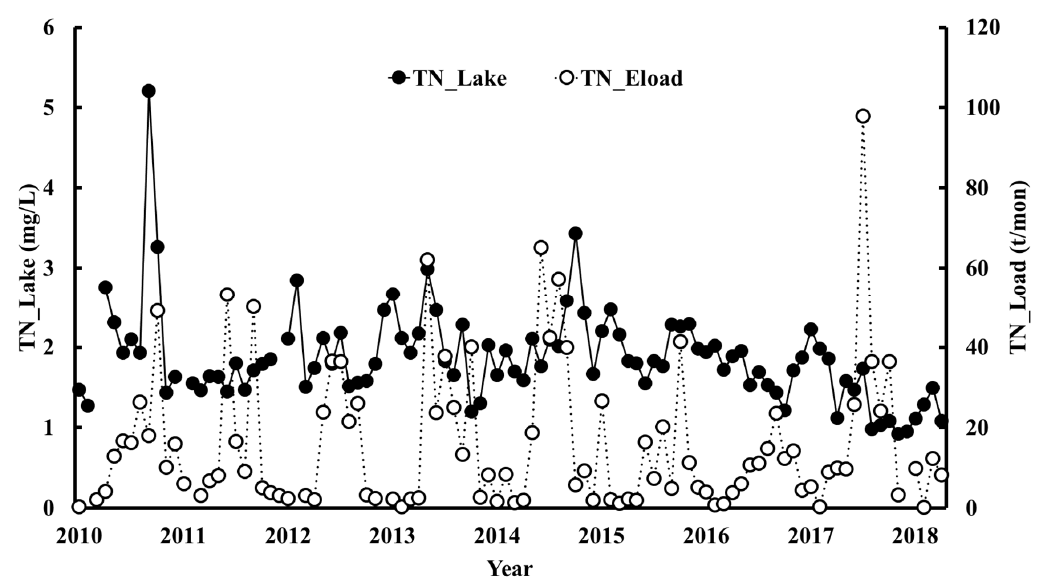
Figure 3. Monthly lake TN concentration (TN_Lake), represented by black solid circles and solid line (left Y axis), and total tributary TN inputs (TN_Eload) represented by black hollow circles and dash line (right Y axis), during January 2010–April 2018.